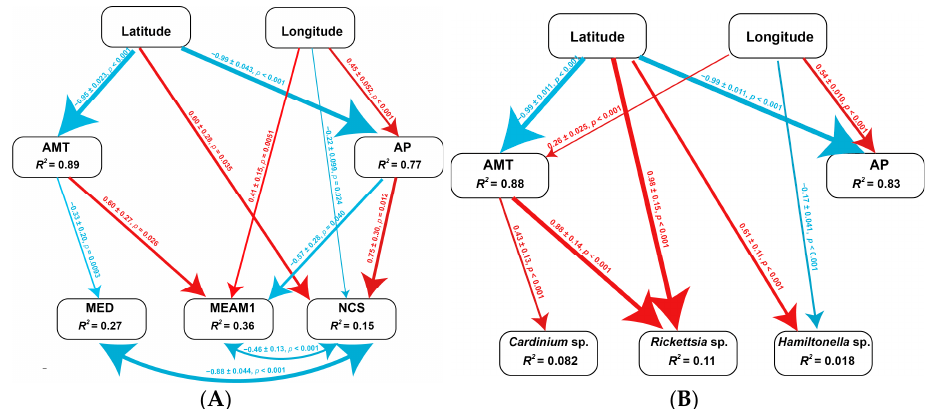
Figure 7. Path diagram for the structural equation model (SEM) for geographic and climatic factors and cryptic species ( A ) and facultative symbionts ( B ) in Bemisia tabaci populations. Statistically significant positive paths are indicated by red arrows. Statistically significant negative paths are indicated by blue arrows. The strengths of these relationships are indicated by the width of the arrows. The R 2 values in each box indicate the amount of variation in that variable explained by the input arrows. Numbers next to arrows are unstandardized slopes. AMT, annual mean temperature; AP, annual precipitation. The infection frequency of Cardinium sp. significantly increased with AMT (0.43 ± 0.13, z = 3.39, p < 0.001), while the frequency of Rickettsia sp. significantly increased with latitude (0.99 ± 0.15, z = 6.76, p < 0.001) and AMT (0.88 ± 0.13, z = 6.71, p < 0.001). The frequency of Hamiltonella sp. significantly increased with latitude (0.61 ± 0.11, z = 4.32, p < 0.001) but decreased with longitude ( − 0.17 ± 0.041, z = 4.16, p < 0.001). Meanwhile, the frequency of Cardinium sp. negatively correlated with that of Rickettsia sp. ( − 0.17 ± 0.041, z = 4.16, p < 0.001); however, the correlations were nonsignificant between Cardinium sp. and Hamiltonella sp. and between Rickettsia sp. and Hamiltonella sp. (Figure 7B). Overall, the infection frequencies of the three endosymbionts may be driven by geographic factors (i.e., latitude, longitude, and altitude) and climatic factors (i.e., AMT and AP) (Table 3). Table 3. Direct and indirect effects of environmental factors on the frequency of Cardinium sp., Rickettsia sp., and Hamiltonella sp. in Bemisia tabaci MED population estimated by the SEM model. Effects Cardinium sp. Rickettsia sp.